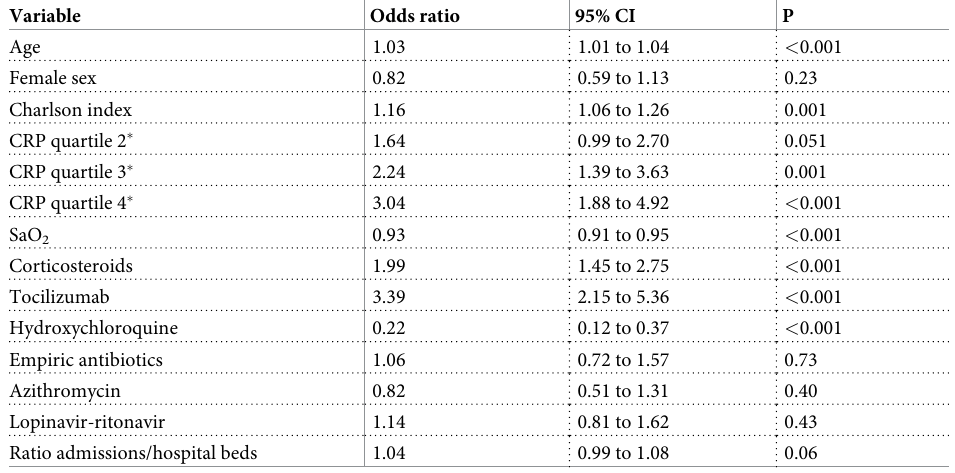
Table 4. Results of the multivariable logistic regression analysis for death or need of mechanical ventilation. Variable